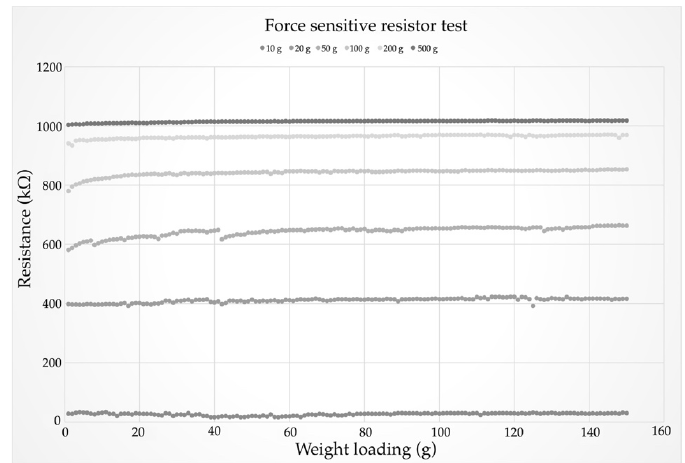
Figure 17. Resistance and weight loading test.